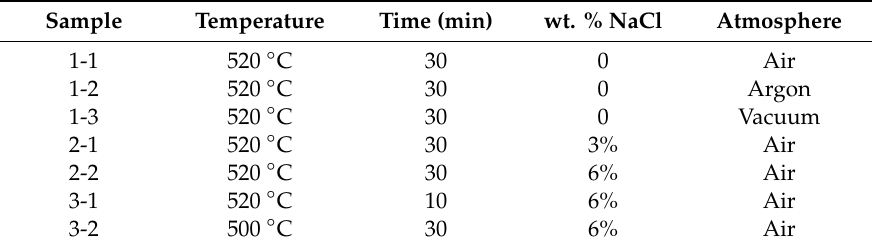
Table 1. The various coating conditions applied in the current research, with bold marking the variable that is changed in the experiment, including thermal treatment’s temperature, time and atmosphere as well as the amount of NaCl added to the glass suspension. Sample Temperature Time (min) wt. % NaCl Atmosphere 1-1 520 ◦ C